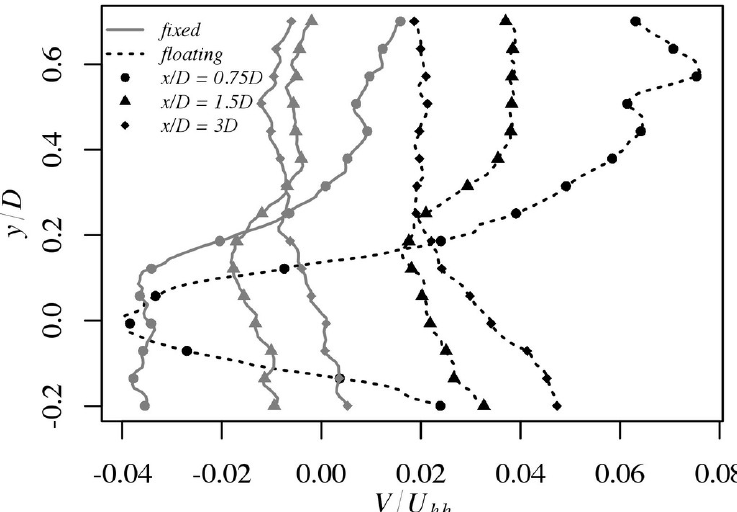
Figure 7. Near wake profiles of V/U distances 0.75 D , 1.5 D and 3 D .